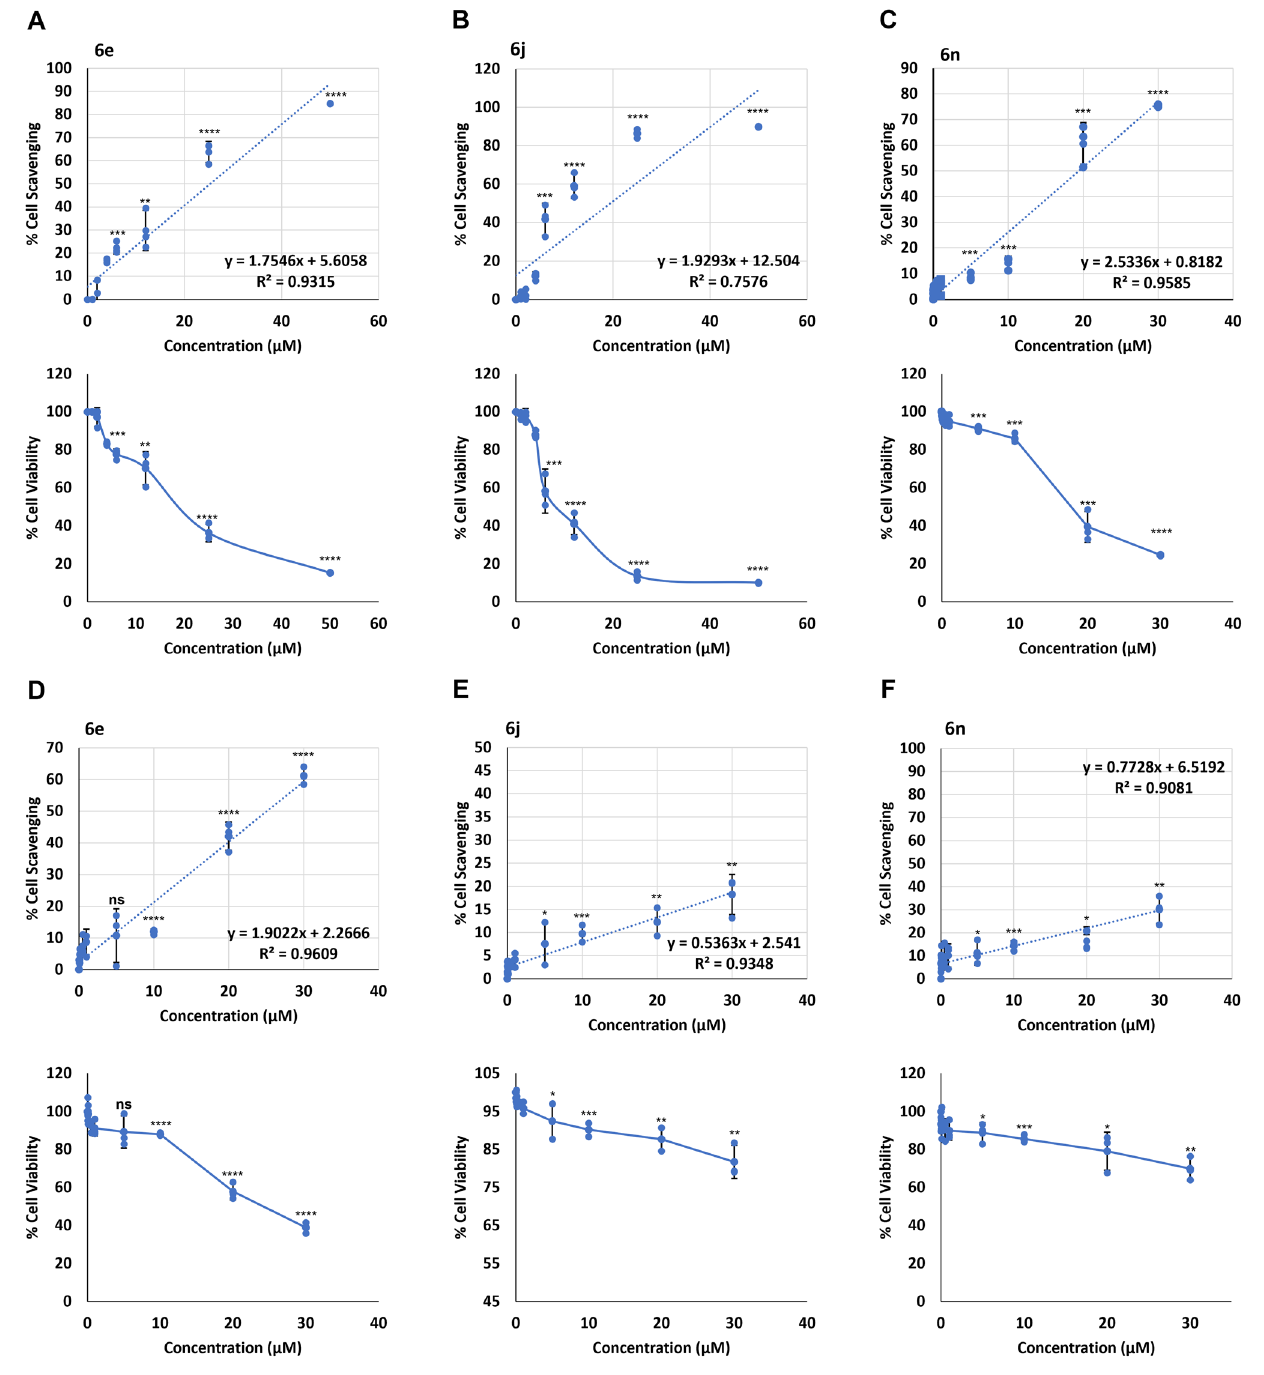
Fig. 5 Effect of cATC derivatives (6e, 6j, and 6n) on cell growth. HeLa cells were treated with indicated amount of 6e , 6j , and 6n for 18 h. A – C Cell scavenging, and cell viability was determined relative to the cells treated with solvent (DMSO) only; N = 3; mean ± SD. D – F , Cell scavenging, and cell viability was determined in HEK293 cells relative to the cells treated with solvent (DMSO) only; N = 3; mean ± SD; two-tailed unpaired Student ’ s t test was used for calculating P values; ns represents non-signi fi cant, * represents p -value ≤ 0.05, ** represents p -value ≤ 0.01, *** represents p -value ≤ 0.001 and, **** represents p -value ≤ 0.0001, N represents experiment